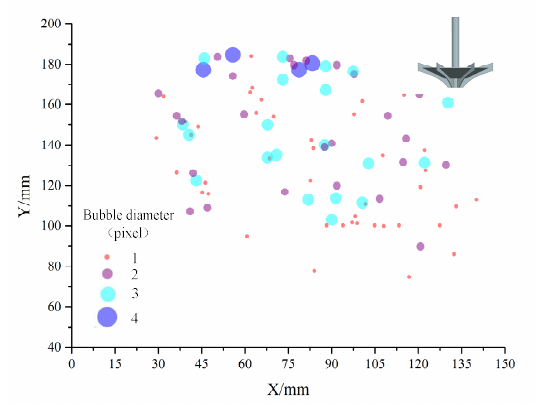
Figure 6. Bubble distribution.